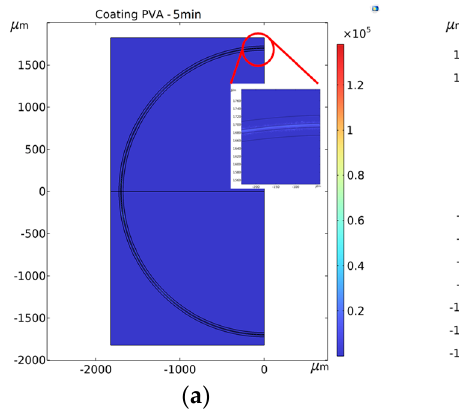
5 min, ( b ) 10 min, and ( c ) 15 min.